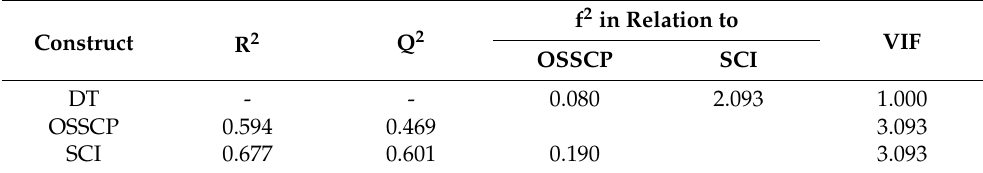
Table 5. Structural model